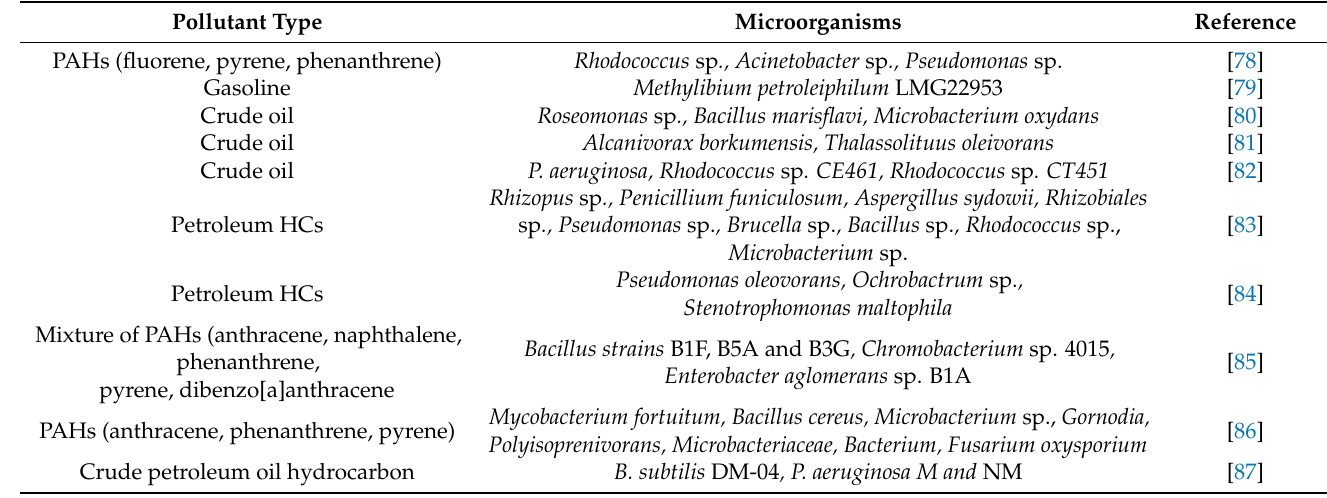
Table 3. Microbial consortia in